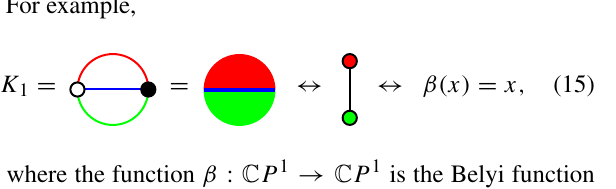
Fig. 1 The dessin embedded in a two-torus